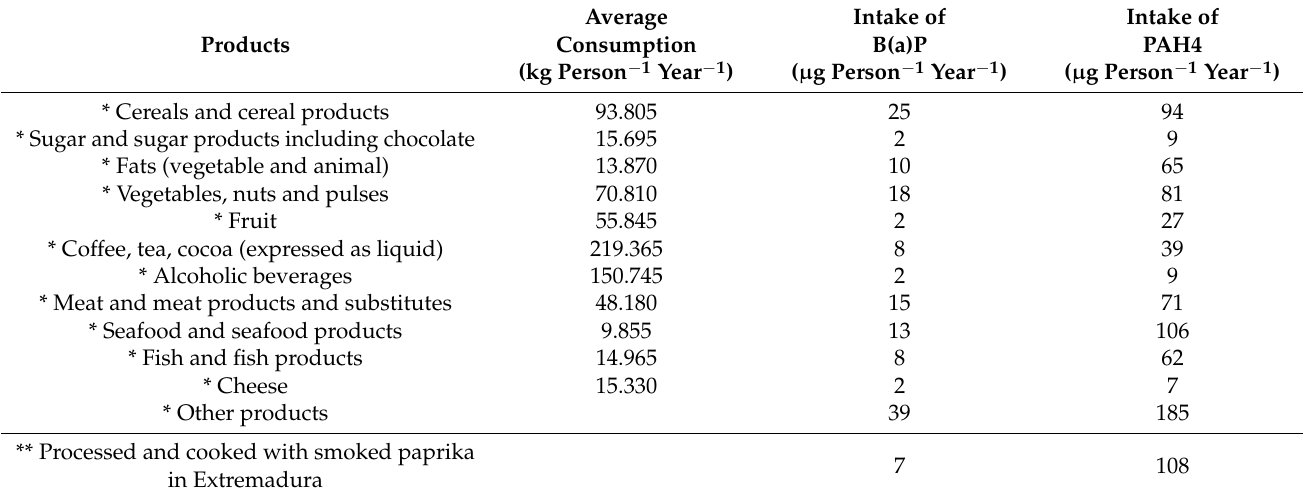
Table 6. Consumer exposure to B(a)P and PAH4 for each food category for which occurrence data are available. (* The average consumption mean value as reported by 16 Member States only from consumers was calculated [12]; ** data corresponding to consumption in